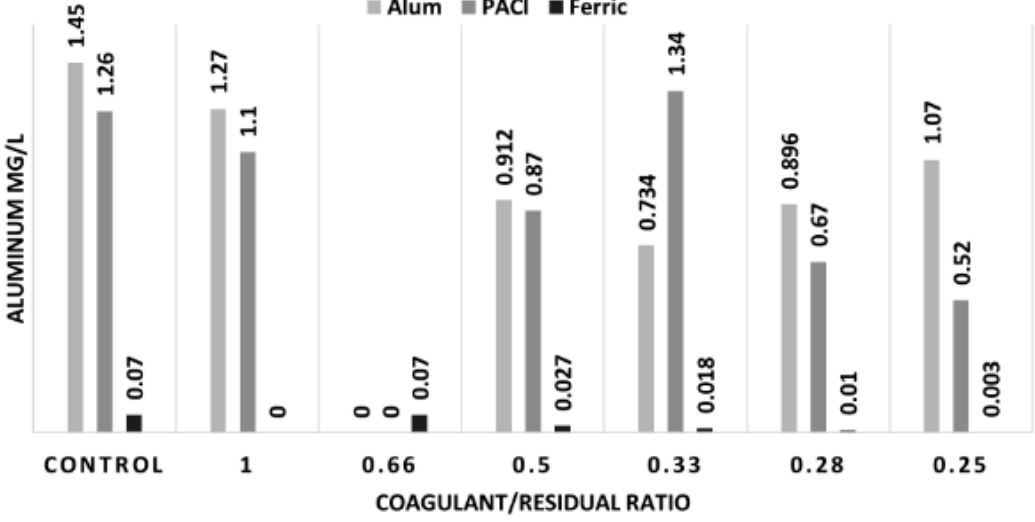
Figure 4. Aluminum residual removal using selected five C/R ratios .